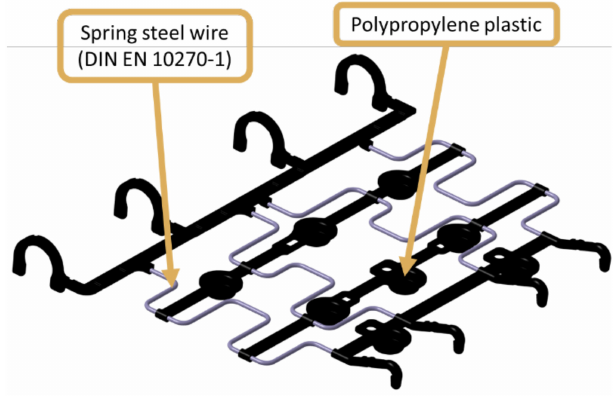
Figure 15. Car seat suspension system: cushion (own